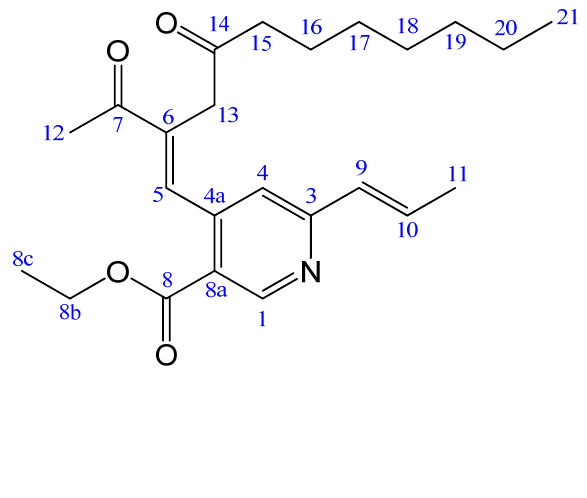
Figure 1. The structure of monapurpyridine